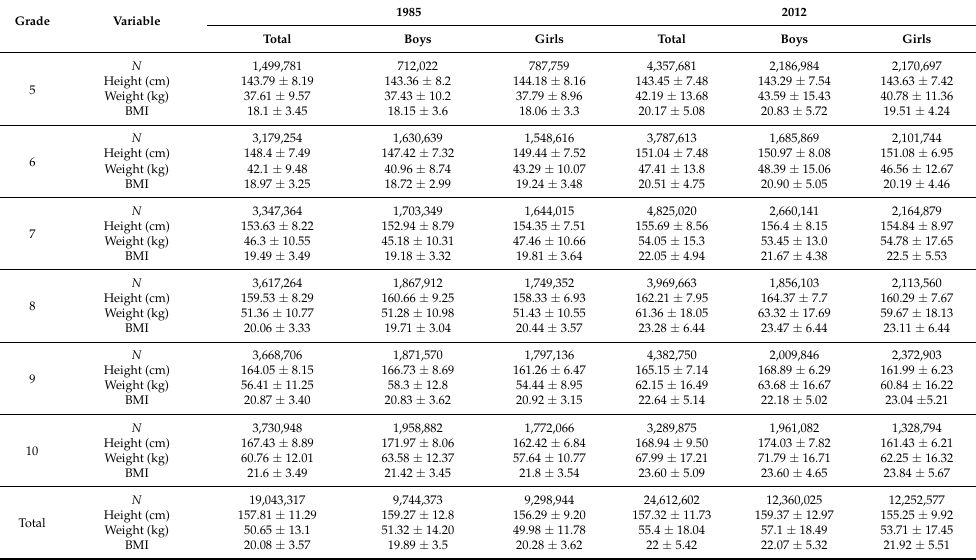
Table 1. Demographics of the students in 1985 and 2012 surveys (mean ±